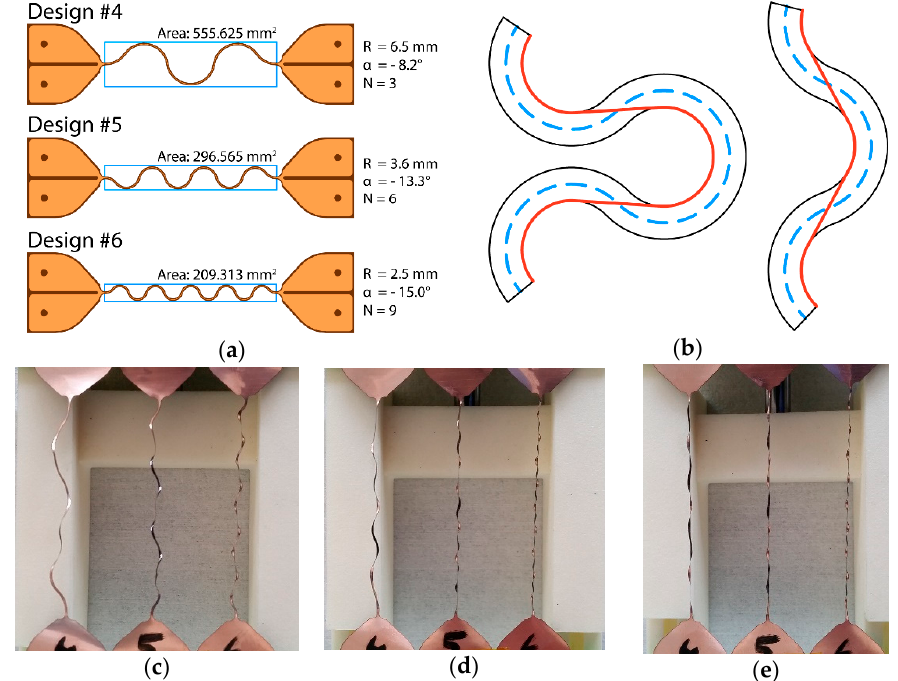
Figure 9. Detailed view of some of the tested samples. ( a ) Parameters and comparison of Designs #4, #5, and #6, illustrating the clear distinctions between designs with similar path lengths. ( b ) The length along the centerline (dashed line) is not the actual length a meander can traverse without undergoing plastic deformation. Instead, the shortest possible distance that traverses the meander track provides a more accurate value. ( c ) Three dummy samples of Design #4, #5, and #6 with a 5 mm extension applied. ( d ) Three dummy samples of Design #4, #5, and #6 with a 10 mm extension applied. ( e ) Three dummy samples of Design #4, #5, and #6 with a 15 mm extension applied.